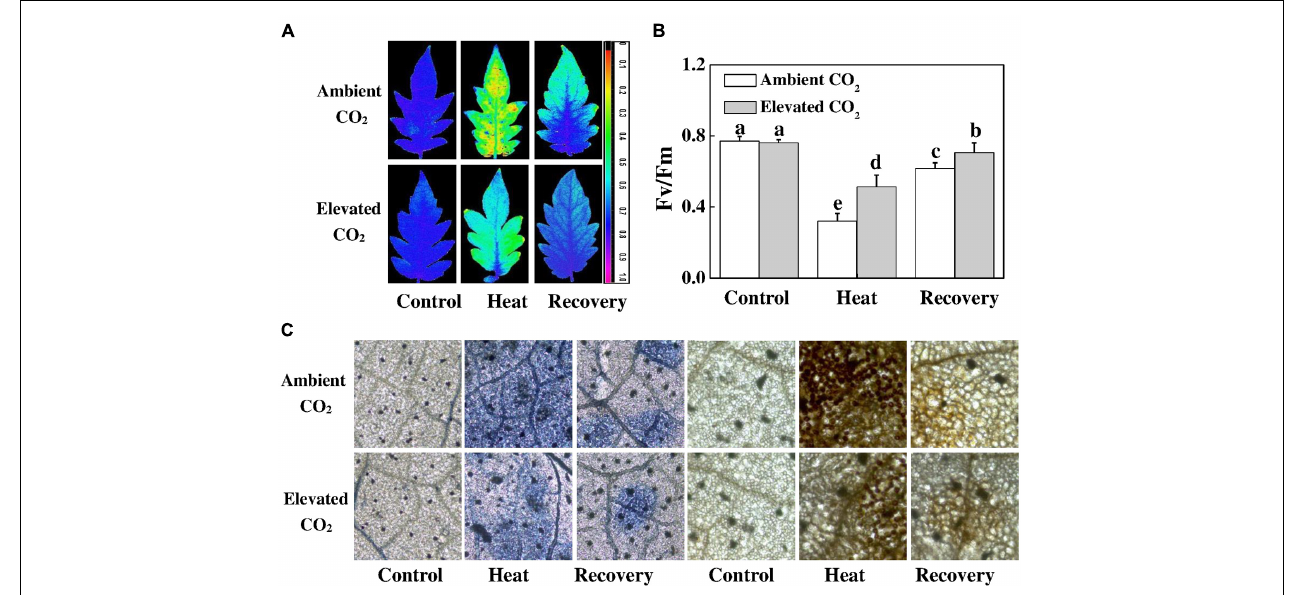
FIGURE 2 | Effects of elevated CO 2 and heat stress either alone or combined on the photosynthetic apparatus and reactive oxygen species accumulation in tomato leaves. (A) the maximum photochemical efficiency of photosystem II (F v /F m ) shown in pseudo color images, the false color code depicted in the image ranges from 0 (black) to 1 (purple); (B) F v /F m values; and (C) in situ accumulation of superoxide (O •− 2 ) and hydrogen peroxide (H 2 O 2 ) by NBT and DAB staining in tomato leaves. Tomato seedlings kept at ambient (380 µ mol mol − 1 ) and elevated CO 2 concentration (800 µ mol mol − 1 ) were challenged with a 24 h heat stress (42 ◦ C temperature) and then allowed to recover for 24 h. F v /F m was measured on the third fully expanded leaves after 30 min of dark adaptation using an imaging pulse amplitude modulated (PAM) fluorimeter (IMAG-MAXI; Heinz Walz, Effeltrich, Germany). The results are expressed as the mean values ± SD, n = 6. Different letters above the bars in (B) indicate significant differences at P < 0.05 according to Tukey’s test.